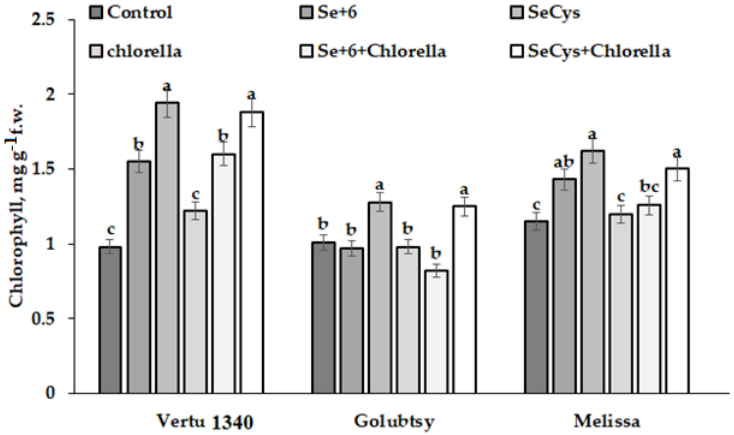
Figure 5. Chlorophyll accumulation in Savoy cabbage as affected by selenium biofortification and Chlorella supply. Values with the same letters do not differ statistically according to the Duncan test at p < 0.05. p <